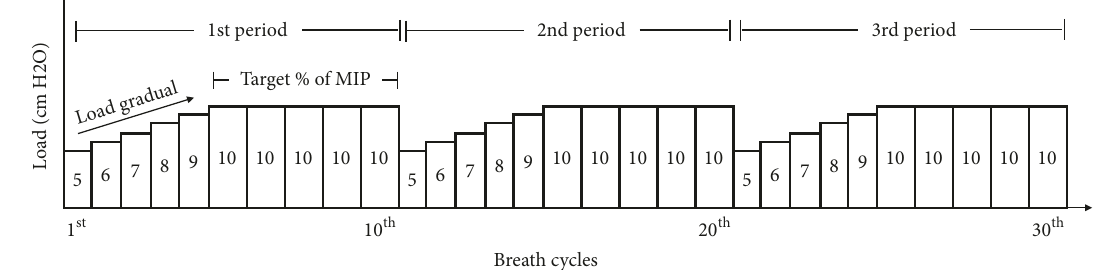
Figure 1: Diagram of the protocol in 3 load cycles each (in each inspiratory muscle training session the procedures were performed twice).